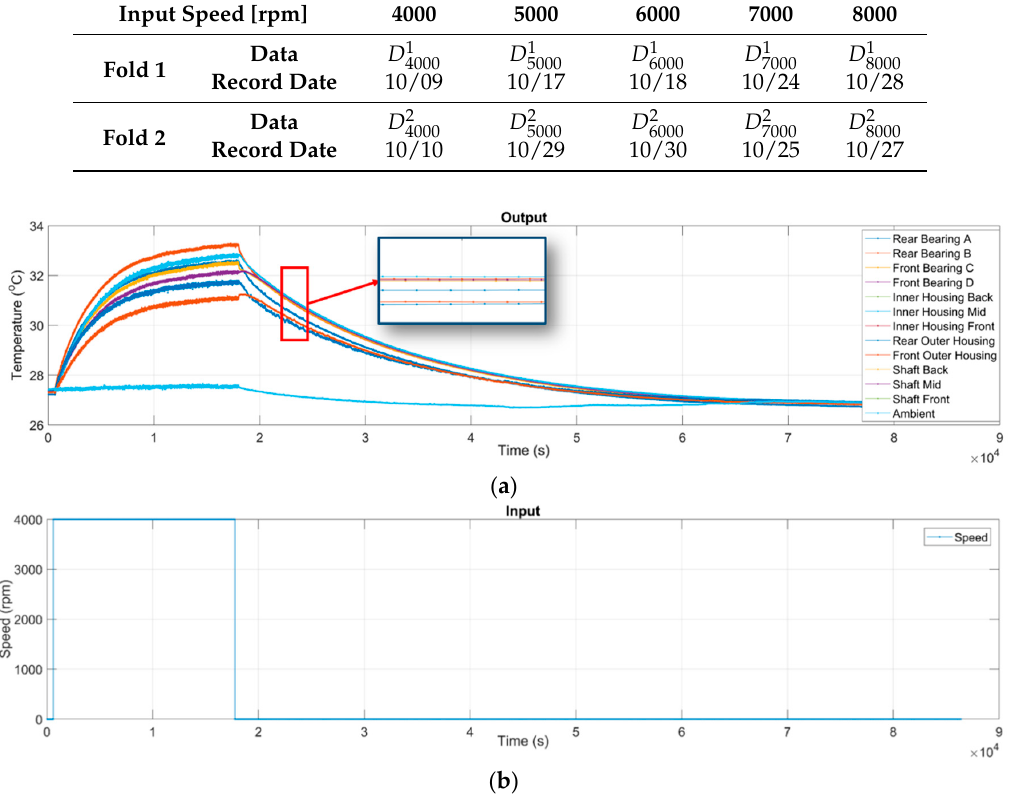
Figure 10. Raw data: ( a ) The time-series of temperatures measured by the TSWTM; ( b ) the time-series of input rotational speed of spindle. Given the case of 4000 rpm as an example.